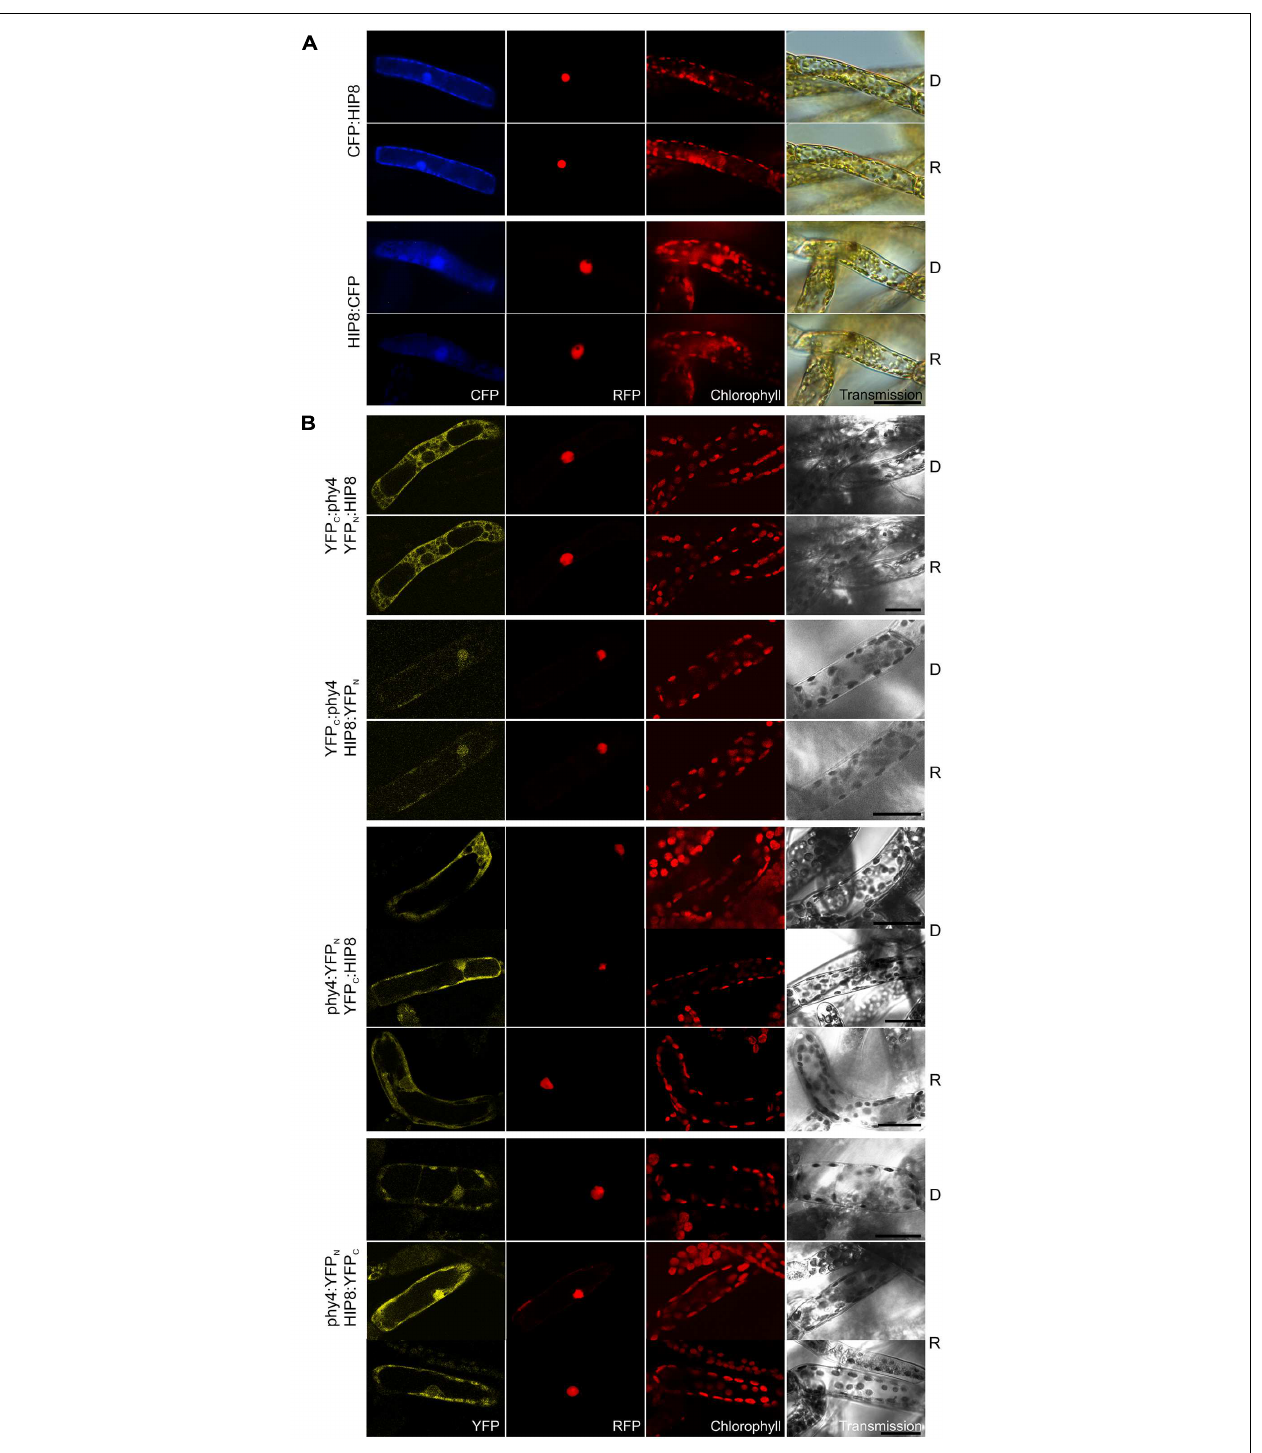
FIGURE 7 | HIP8 (Pp3c11_25550V1.1) intracellular localization (A) and split-YFP-studies of HIP8–phy4 interaction (B) each without (D) and with R pre-treatment (R) using fluorescence- and confocal microscopy, respectively. Overall figure structure is analogous to Figure 1 . (A) CFP:HIP8- (rows 1 and 2) and HIP8:CFP-fluorescence (rows 3 and 4) was observed in nucleus and cytoplasm (column 1, CFP). (B) All four split-YFP configurations were studied, however, in the case of YFP N :phy4–YFP C :HIP8 and YFP N :phy4–HIP8:YFP C the negative controls showed significant signals (thus these configurations were replaced